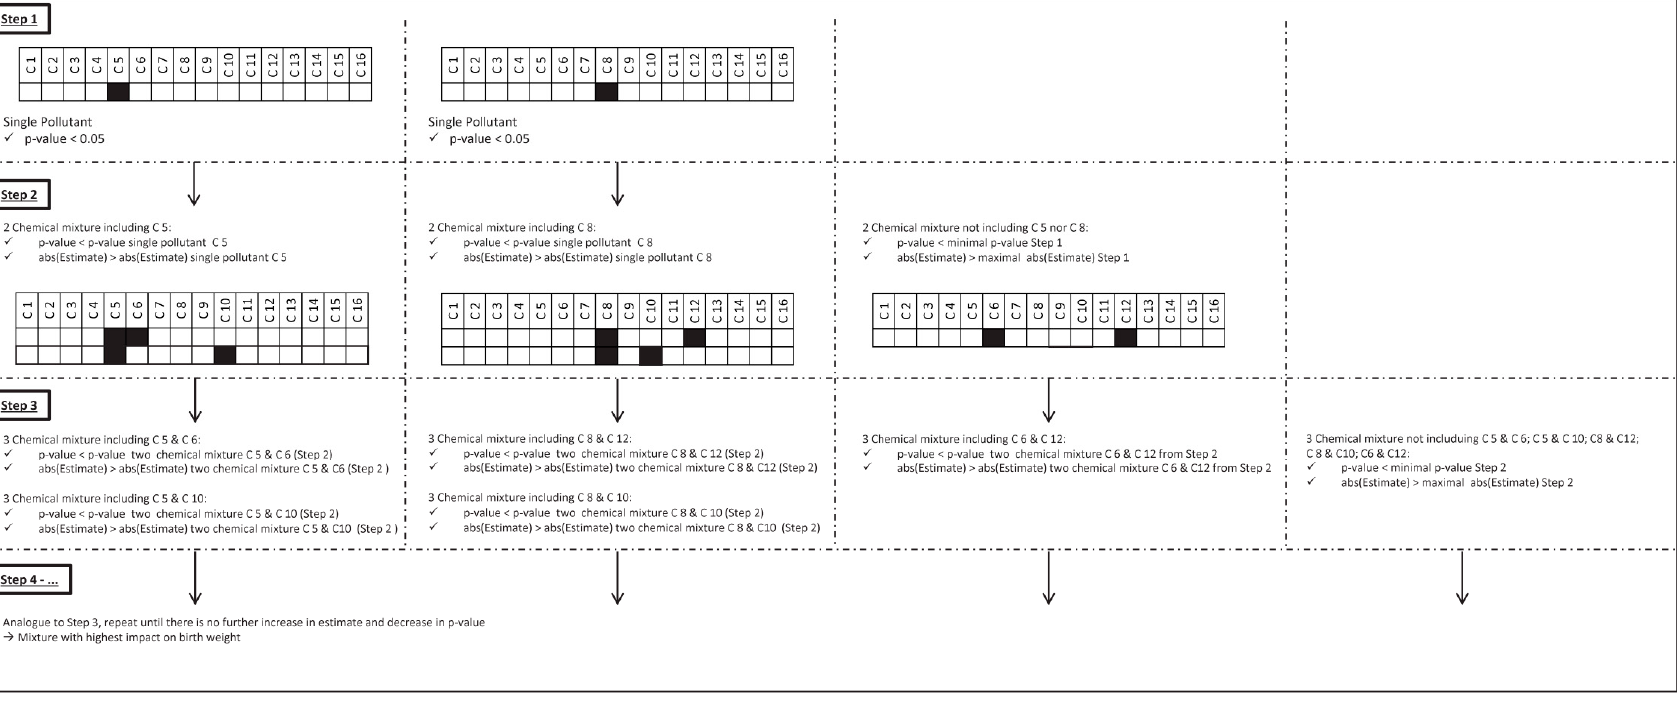
Figure 1. Mixture regression algorithm. Starting from single pollutant models, significant associations ( p -value < 0.05) between exposure and birth weight were selected. Alternatively, when significant associations at single pollutant level were lacking, the single pollutant association with the highest rank (based on p -value) was selected. Next, the association of mixtures composed of N chemicals was evaluated by comparing to the association of N-1 chemicals. The criteria to identify models having a stronger association as compared to least complex mixtures were based on the strength of the estimate and p -value of the association between the average mixture z-score and birth weight.